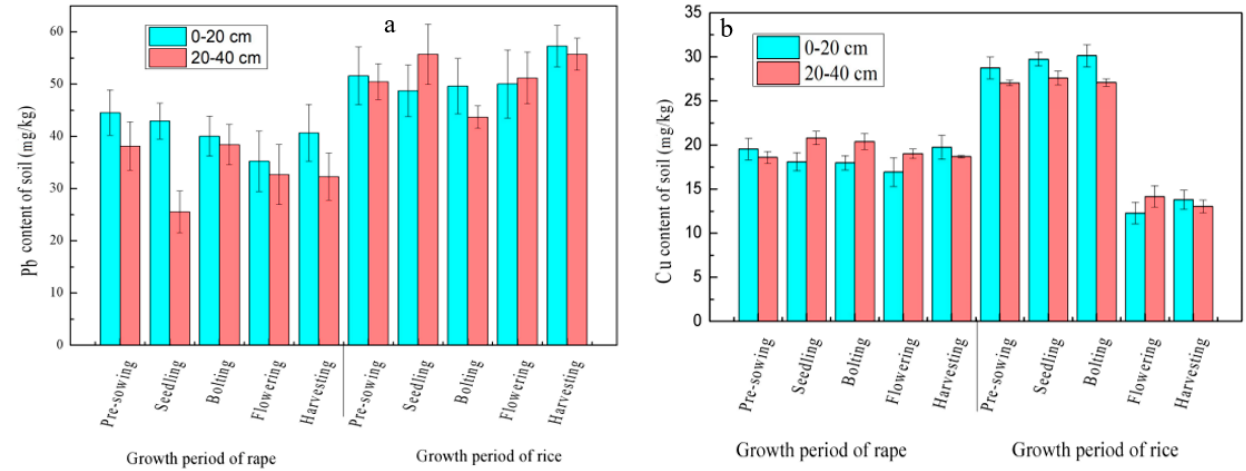
Figure 5. Change of heavy metal Pb ( a ) and Cu ( b ) in soil during rice–rape rotation. 3.3. Evaluation of the Soil Pollution by Heavy Metals in Rice–Rape Rotation